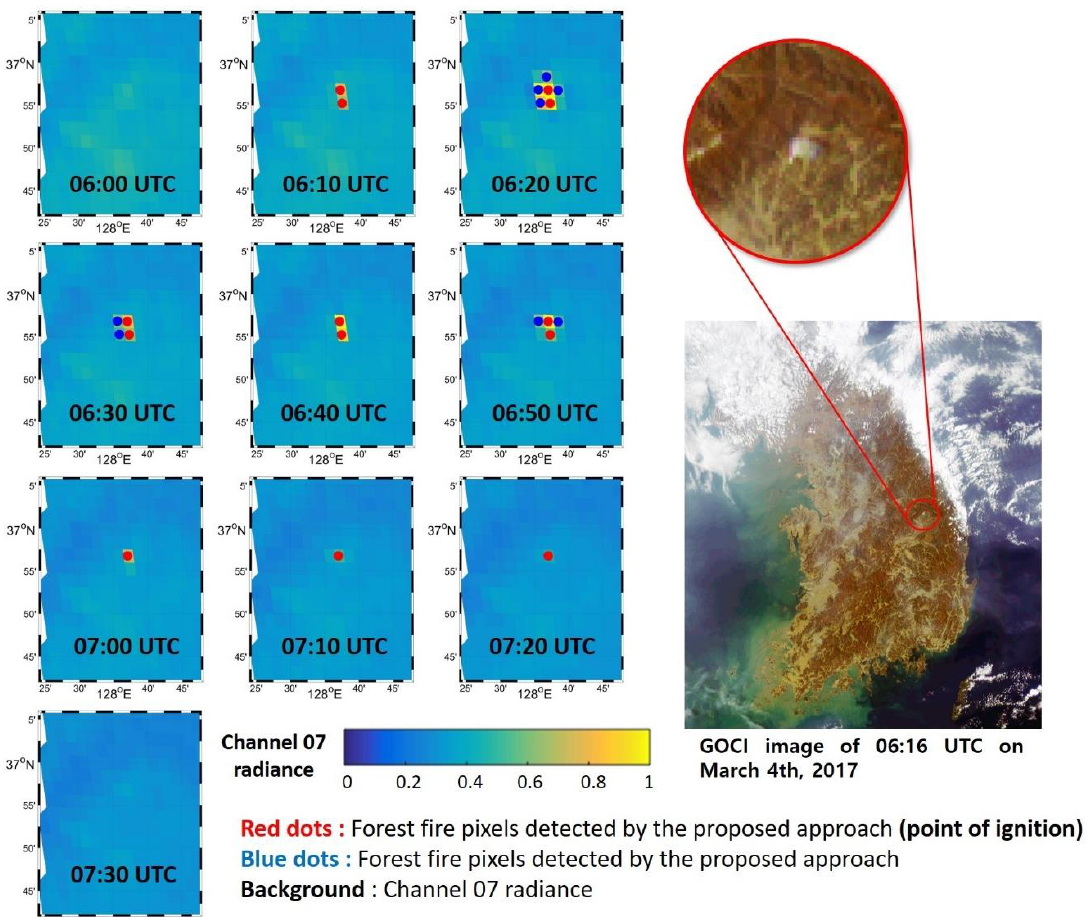
Figure 6. Forest fire in Yeongju-si, Gyeongbuk and Geostationary Ocean Color Imager (GOCI) image on the 4th March 2017. The fire monitoring results from 6:00 to 7:20 UTC by the proposed algorithm (red and blue dots) are shown with the band 7 radiance of Himawari-8 AHI as the background.